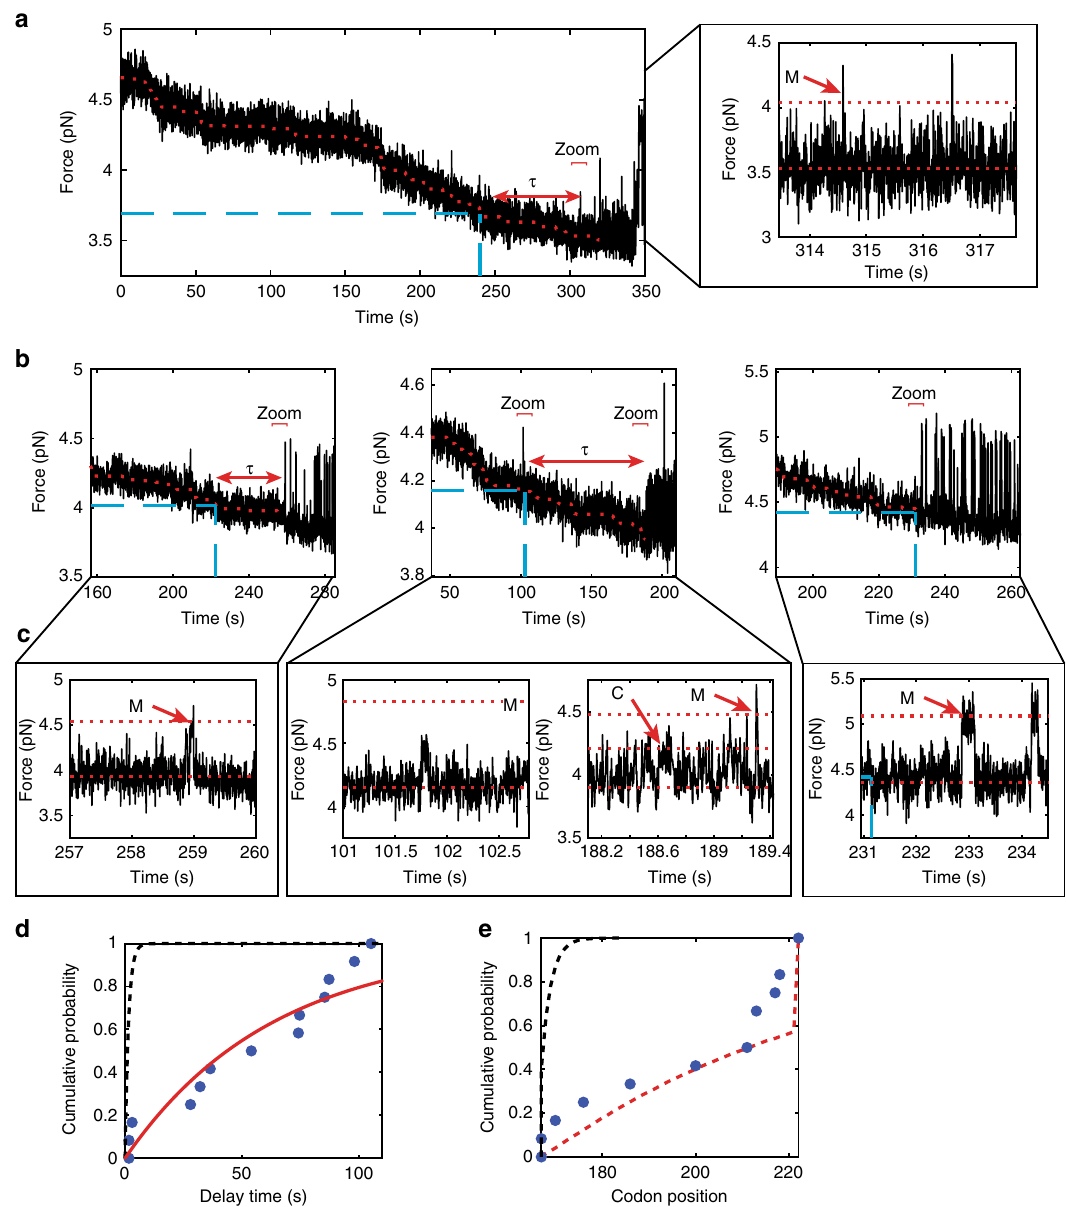
Fig. 5 Translating RNCs have a non-equilibrium delay prior to folding. a An example trajectory showing full translation of the sequence in force versus time. The blue dashed line corresponds to codon 167, when folding would begin in equilibrium conditions. τ indicates the observed delay. The inset shows a zoom to the folding region shown at higher bandwidth (267 Hz) to see the folding transitions. b Example trajectories zoomed to show just the region after passing codon 167 (blue dashed line) to the onset of folding, either the misfolded state (1st example), the C domain (2nd example), or the misfolded state with an equilibrium-like delay (3rd example). c Zoom in regions of the data in b at higher bandwidth (267 Hz) show the folding transitions. For the spike in b in the middle panel at 101.5 sec, the zoom shows that this transition is a rare event that does not correspond to N, C, or M folding as it is too small. This event does not reoccur, and was not scored as the onset of equilibrium-like folding. d The observed delay time empirical cumulative distribution function (blue dots). An exponential fi t is shown as a red line, whereas the expected distribution for time until folding based on simulations using stalled RNC data is shown as a black dotted line. e Using our fi t to codon position, we can also record the codon where folding fi rst occurred (blue dots). This is compared with a simulation of equilibrium conditions (black dotted line) and a simulation assuming an additional delay step of 63 sec (red dotted line). Source data are provided as a Source Data fi